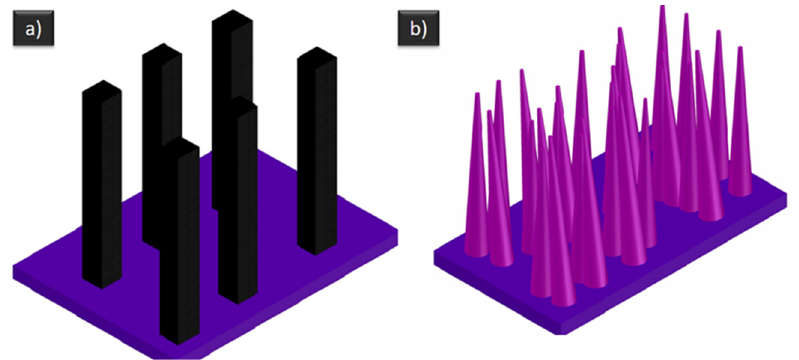
Figure 4. Schematic models of nanostructures reported in the literature: ( a ) nanorods and ( b ) nano- cones.